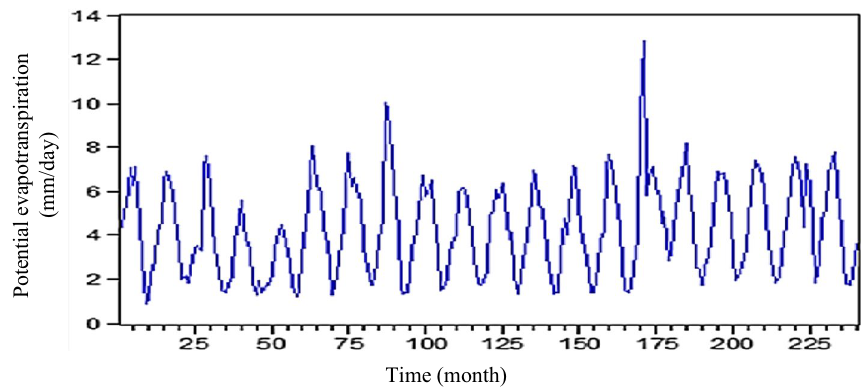
Fig. 1 Evolution-Evapotranspi- ration Potential from the first month of the year 1993 to the last month of 2012 by the FAO Penman–Monteith method